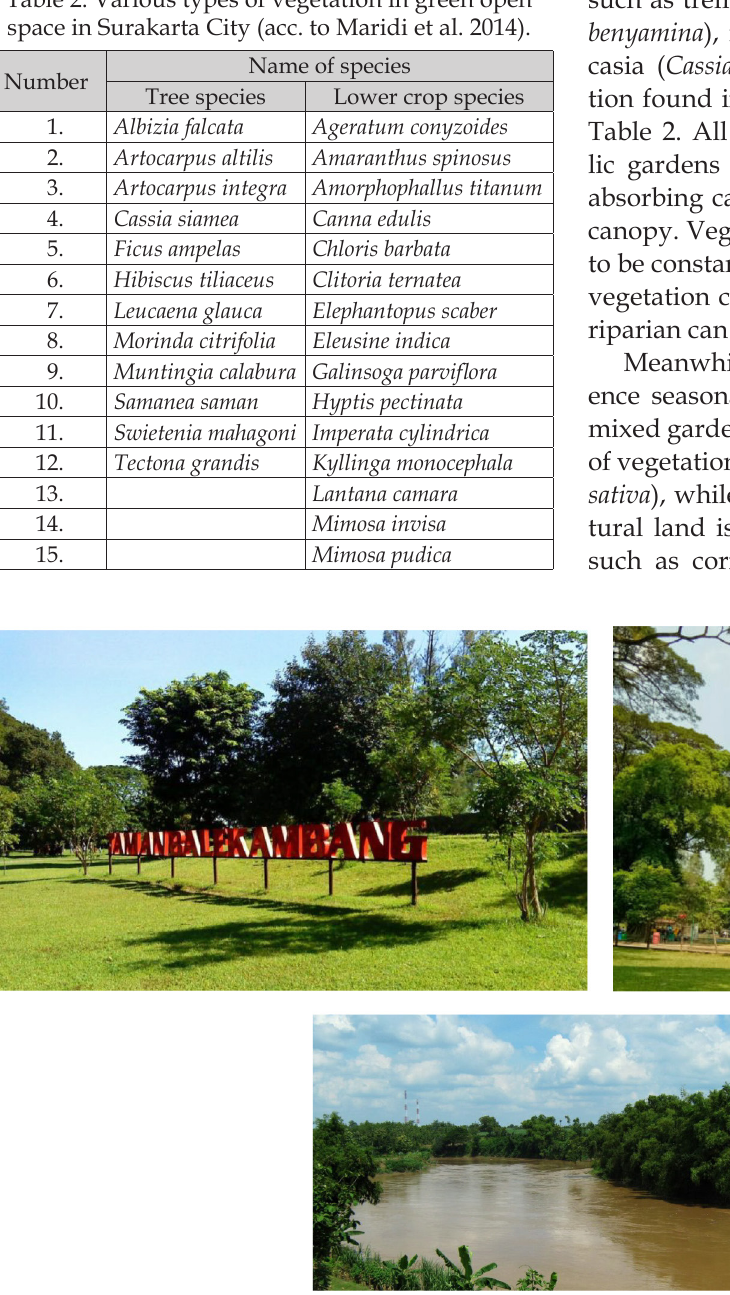
Fig. 5. Vegetation conditions in city/public garden and